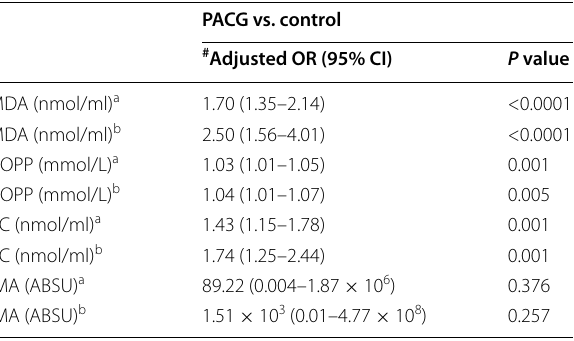
Table 4 Association between markers of systemic oxidative stress and PACG risk using binary logistic regression